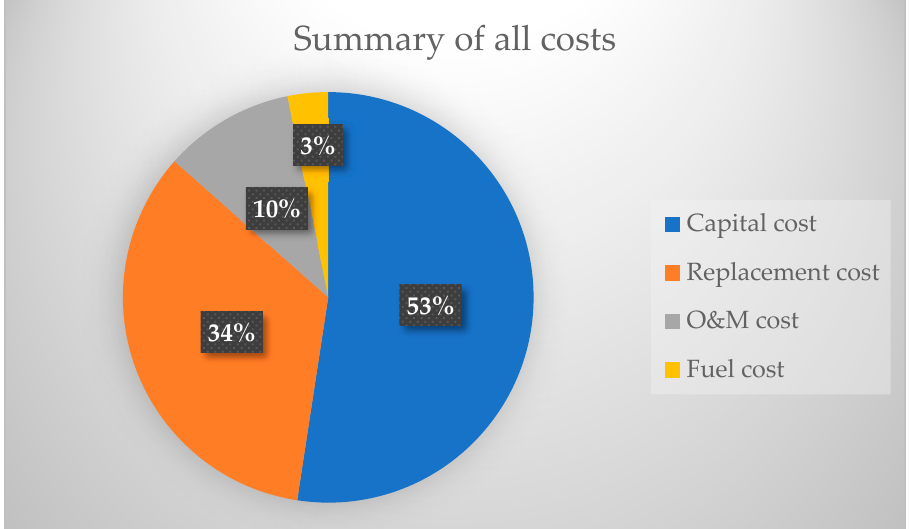
Figure 10. Percentage composition of the various cost of the